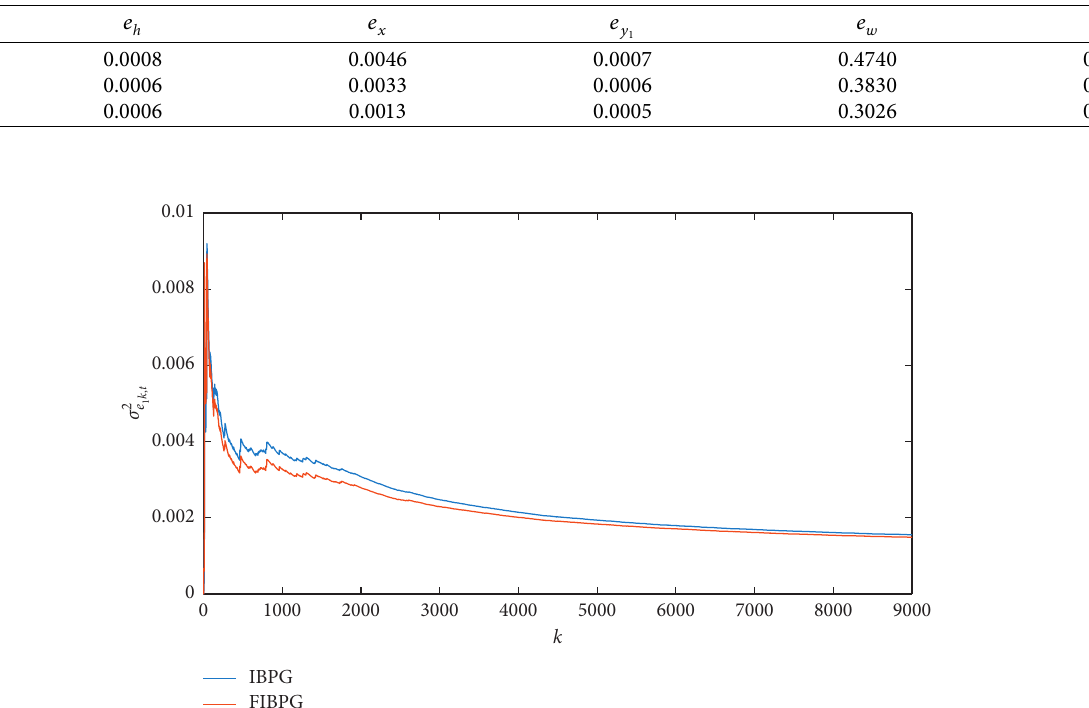
Figure 9: Evolution curves of estimation error variance for the FSOEAHW model using FIBPG algorithm.